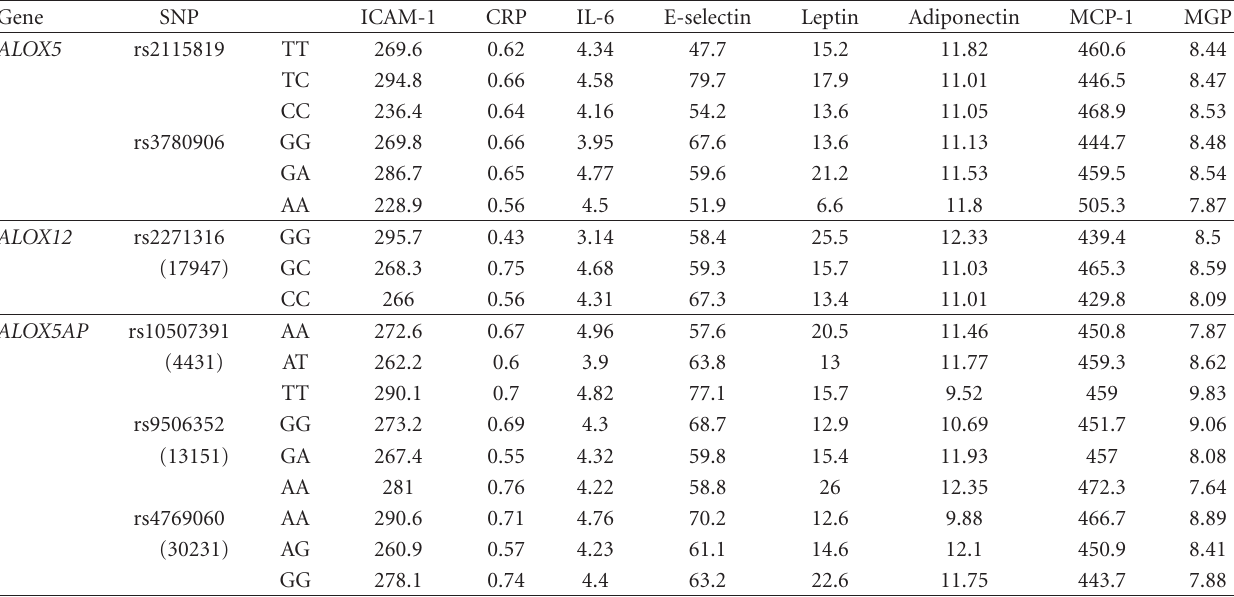
Table 5: Association of lipoxygenase variants in ALOX5 , ALOX5AP, and ALOX12 with mean levels of biomarker phenotypes. Gene